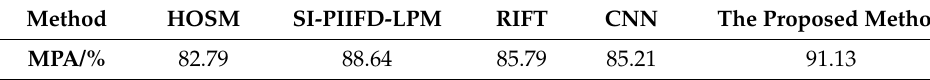
Table 1. The average matching points accuracy (MPA) of five methods.